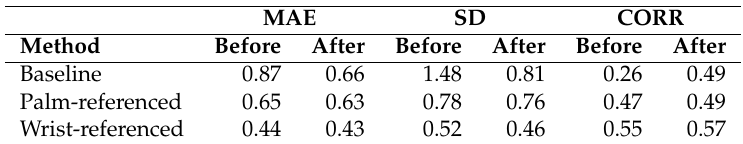
Table 4. Effect of outlier